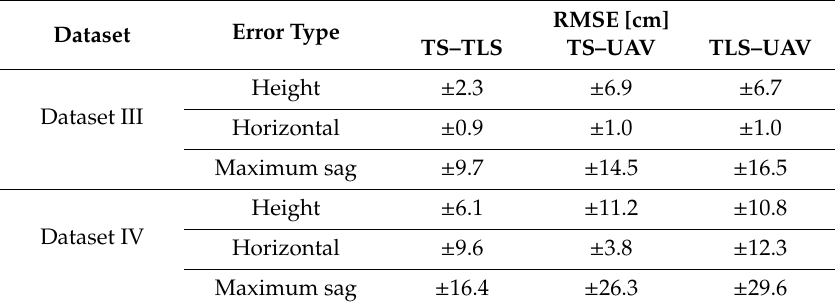
Table 7. The accuracy of wire reconstruction using the proposed method.